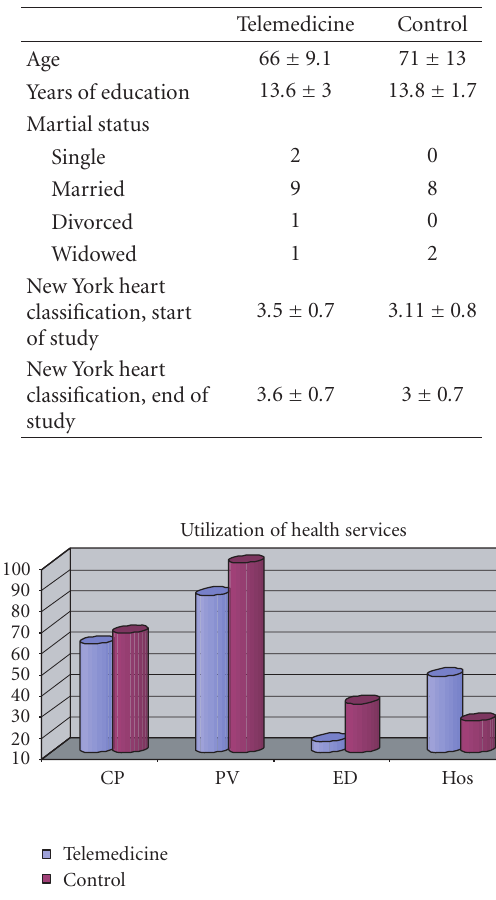
Figure 1: Percent of patients who contacted their physician (CP), visited their physician (PV), utilized the emergency department (ED), and/or were hospitalized